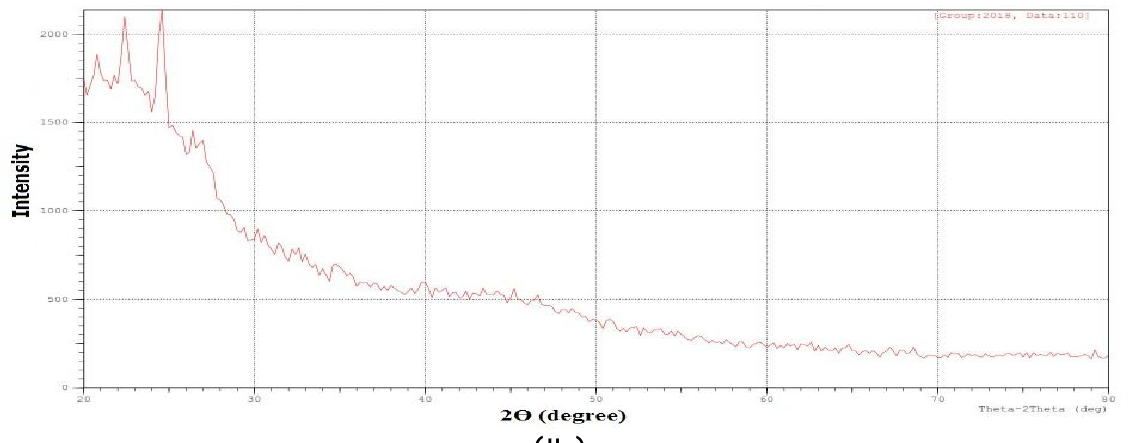
Figure (1) X-ray diffraction patterns of silymarin (A) , gelatin(B), MC9 (C), MC1 (D), MC10 (E),MC9s (F), MC1s (G), MC10s (H) Differential scanning calorimetry